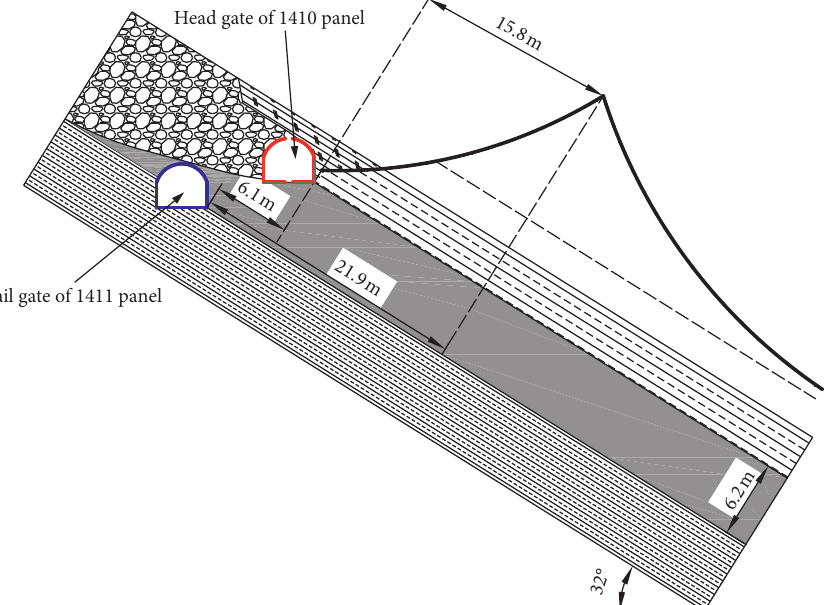
Figure 12: Schematic diagrams of roadway position relationship.